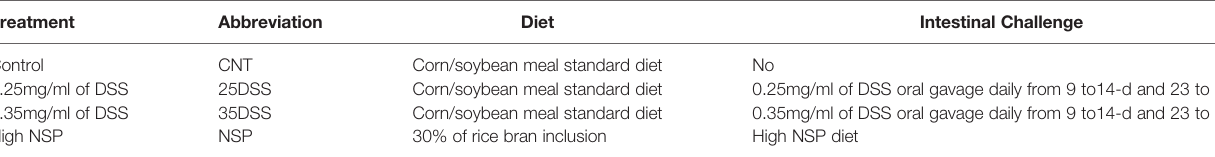
TABLE 1 | Experimental treatments.